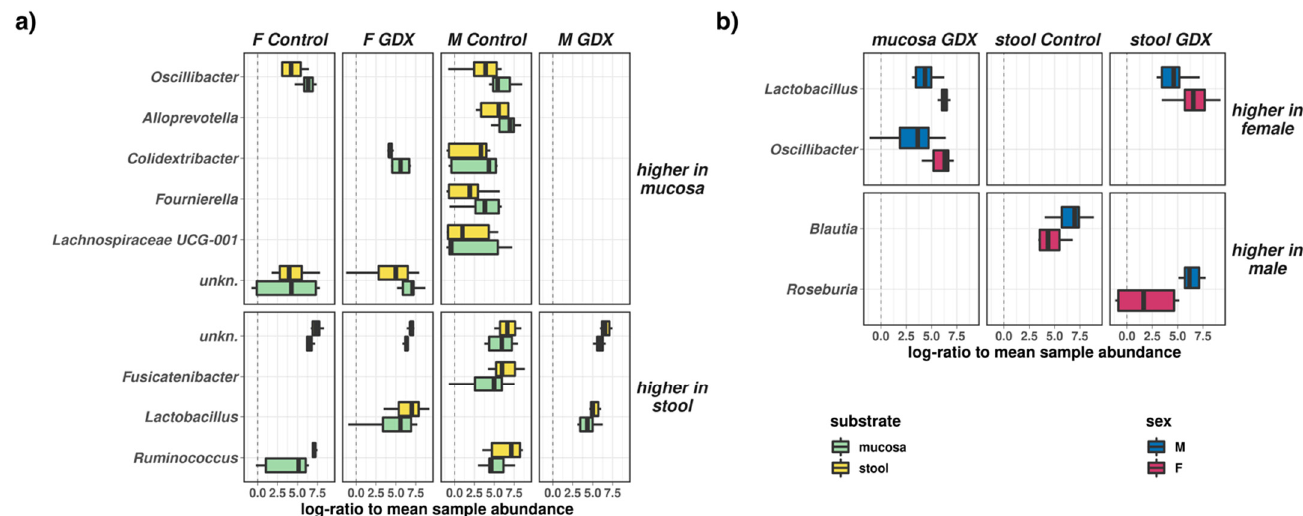
Figure 4. Differential effects of sex and substrate on the abundances of individual microbial genera. ( a ) Taxa which were differentially abundant (FDR < 0.05) between mucosal and stool samples for different groups across the experimental design. ( b ) Taxa which were differentially abundant (FDR < 0.05) between female and male samples for different groups across the experimental design.